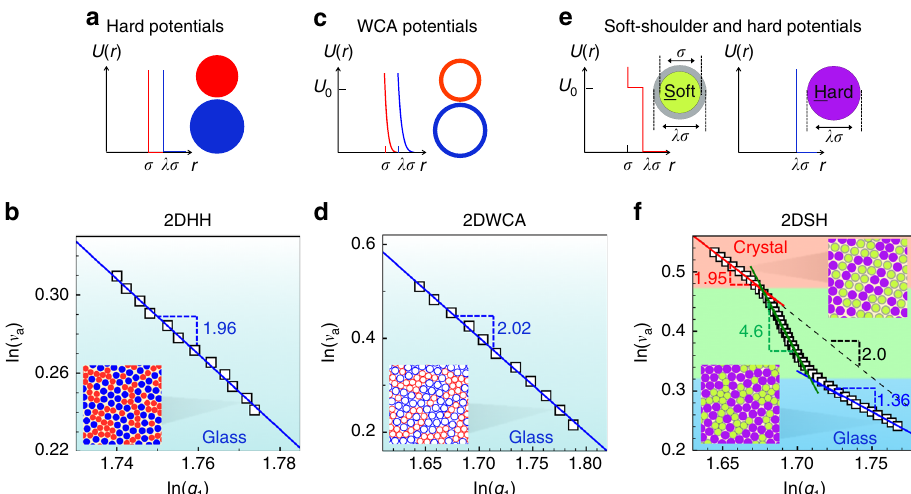
/ q (cid:2) d with d ≃ 2.0 1 a ¼ q (cid:2) 2 1 a